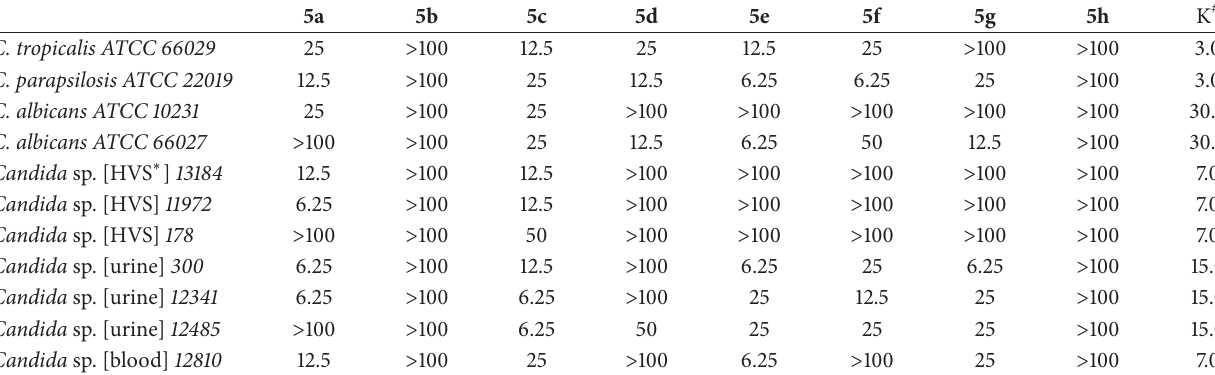
∗ HVS: high vaginal swab; K # :